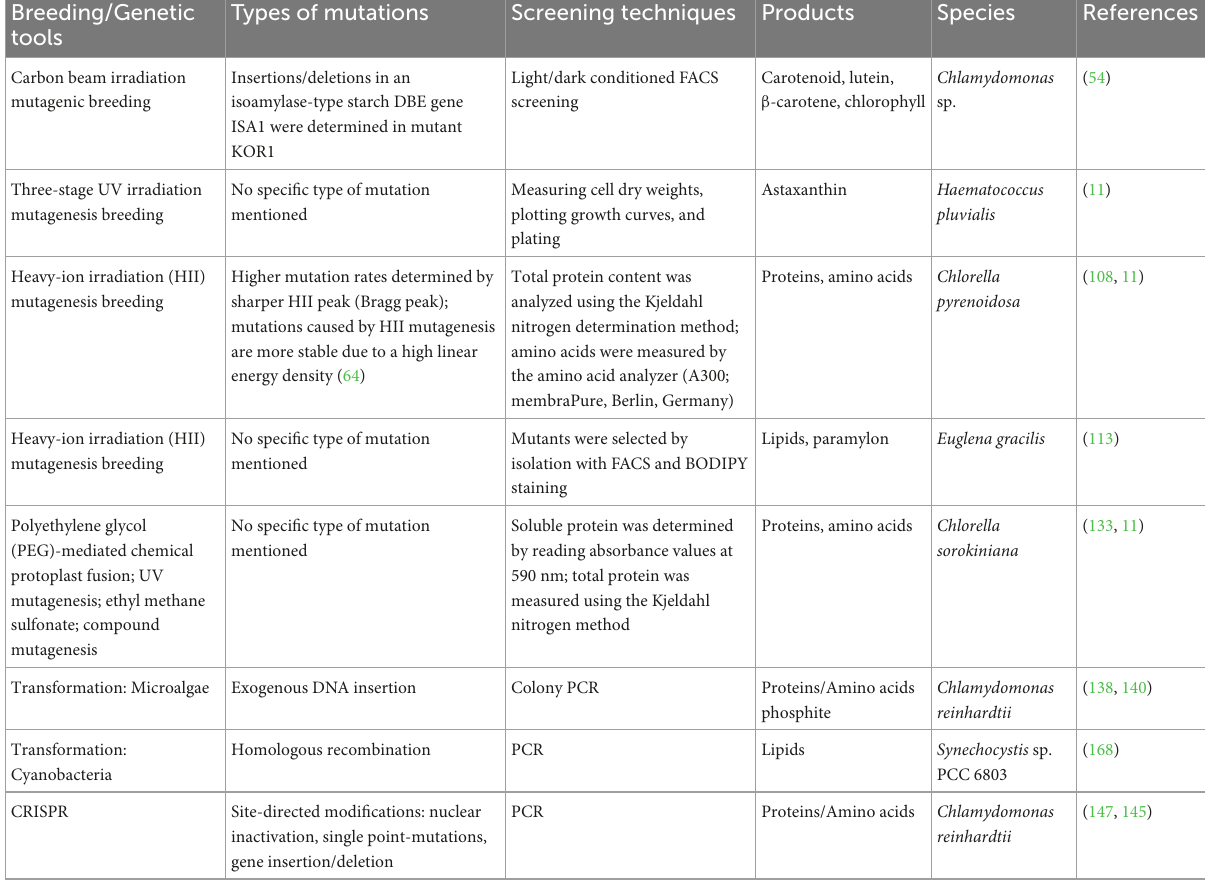
TABLE 2 Summary of breeding methods and genetic tools used to enhance the production of desirable